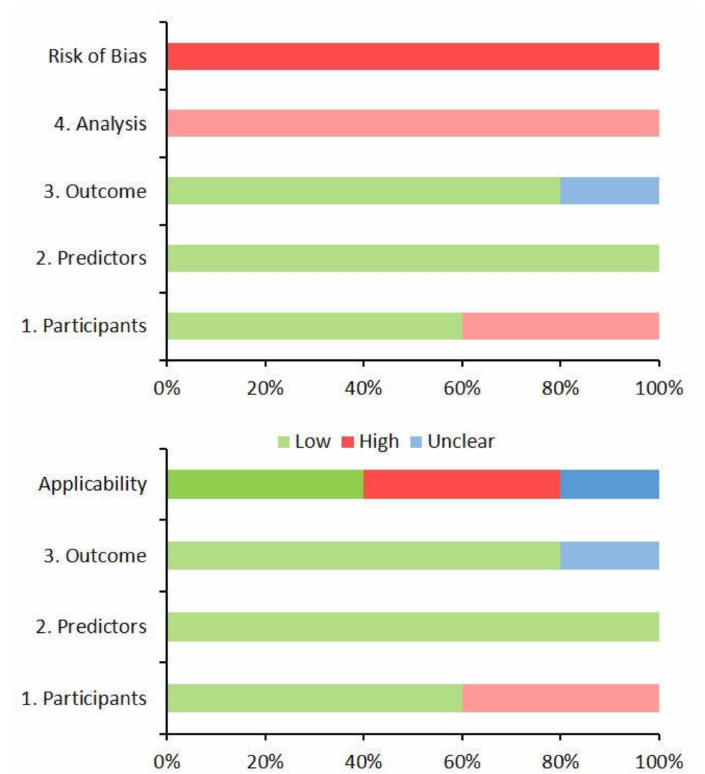
Figure 5. The risk of bias and concern regarding the applicability of the models developed in the five prediction modelling studies for pregnancy complications in women with gestational diabetes using the Prediction model Risk of Bias Assessment Tool (PROBAST). The x -axes display the proportion of studies rated by level of concern (low, high or unclear) for risk of bias or applicability for each